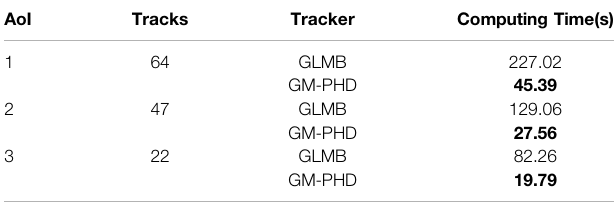
TABLE 7 | Computing times for modi fi ed GM-PHD and GLMB fi lters. AoI Tracks